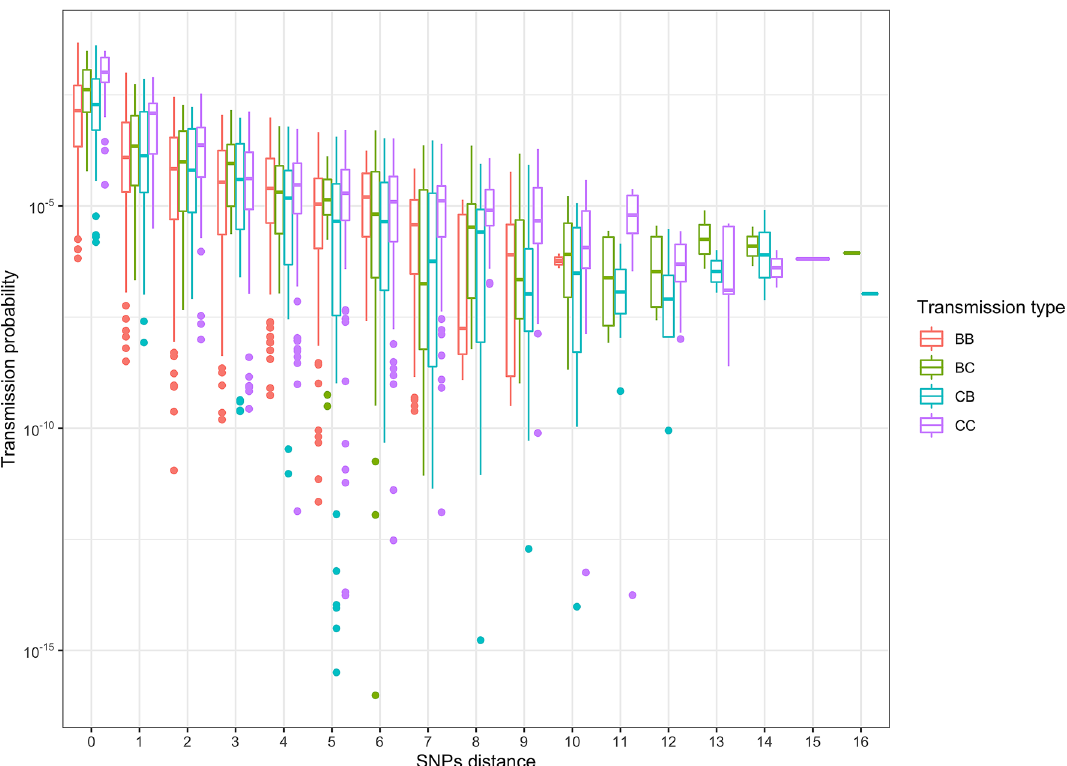
Figure 1. Pairwise transmission probability. The pairwise transmission probability (y-axes) for each host pair versus the SNP distance (x-axis). To calculate the probability we used the following parameters distributions: substitution rate ( μ ), beta-PERT (0.1, 0.31, 0.94 base pair × genome × year); latency period ( 1/σ ) beta-PERT (116, 348, 827.5 days); contact rate ( β ) ∈ uniform (0, 0.1) × contact ×